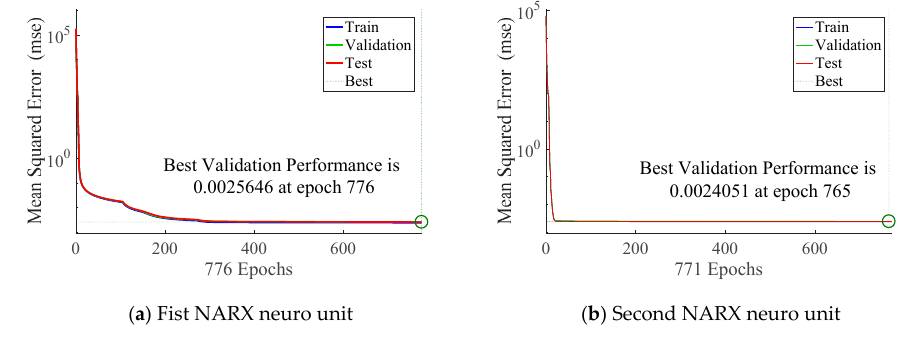
Figure 6. Training results of NARX in integrated filter.